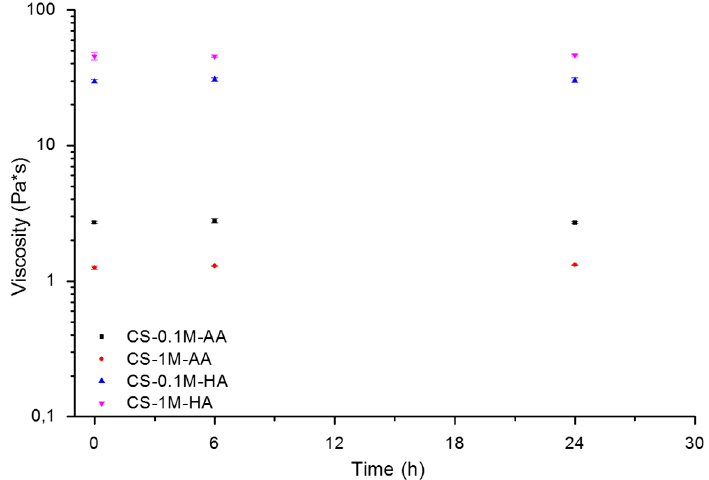
Figure 3. Viscosity of the different sample solutions stored for different time points at 4 °C. Please note that some symbols overlap the standard deviation bars.